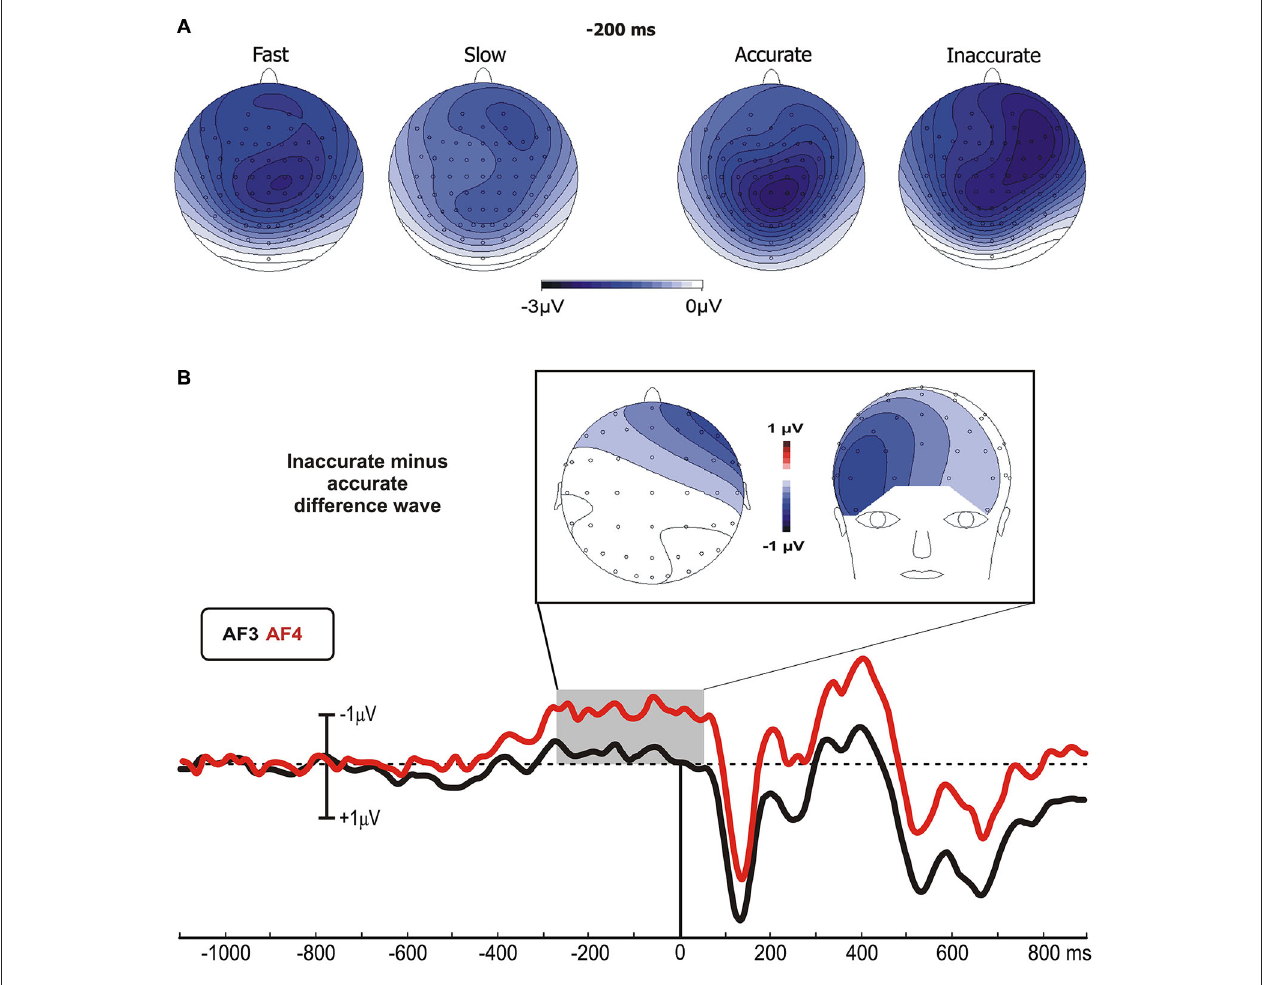
sites of the left and right PFC pools of the differential activity in the Accuracy-groups (inaccurate minus accurate group). Time 0 corresponds to the stimulus onset.